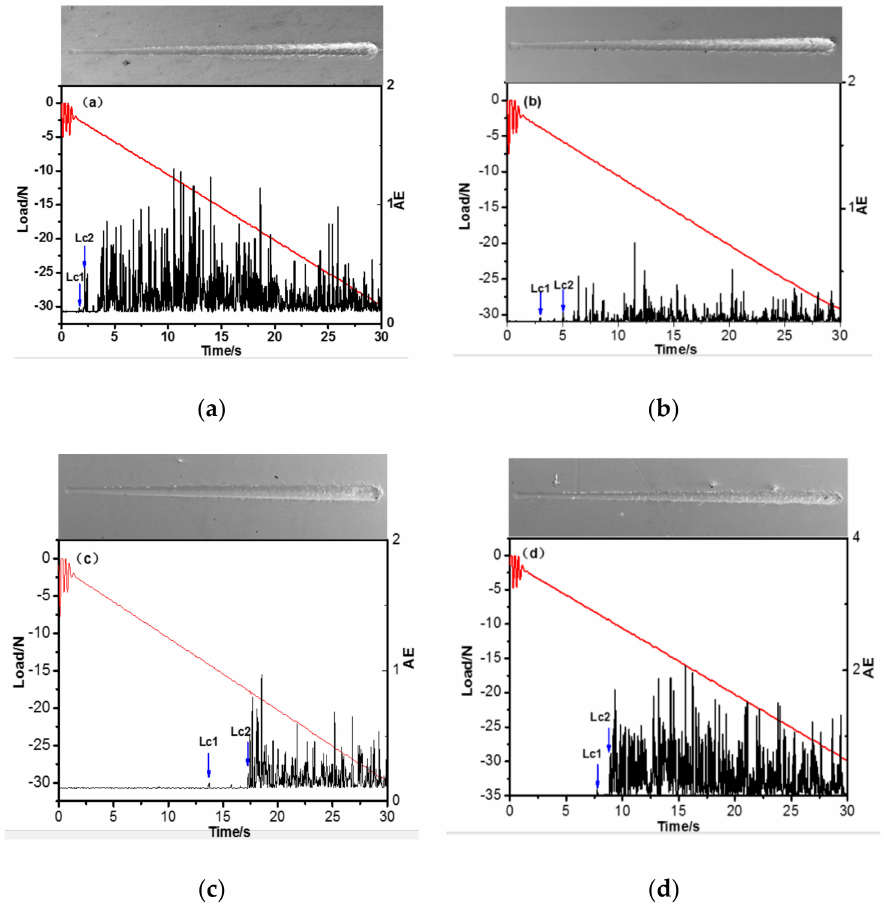
Figure 6. The scratch morphologies and results of scratch test of the ( a ) TiN-0.25 ( b ) TiN-0.35